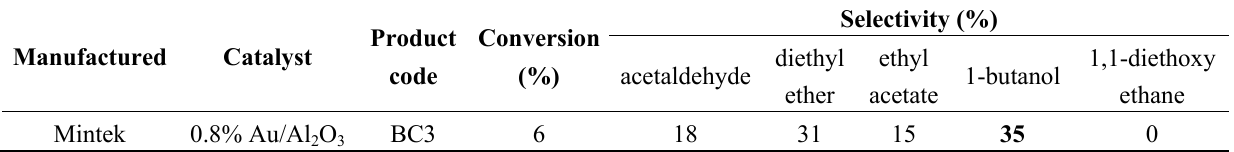
Table 9. Results obtained with alumina supported Au